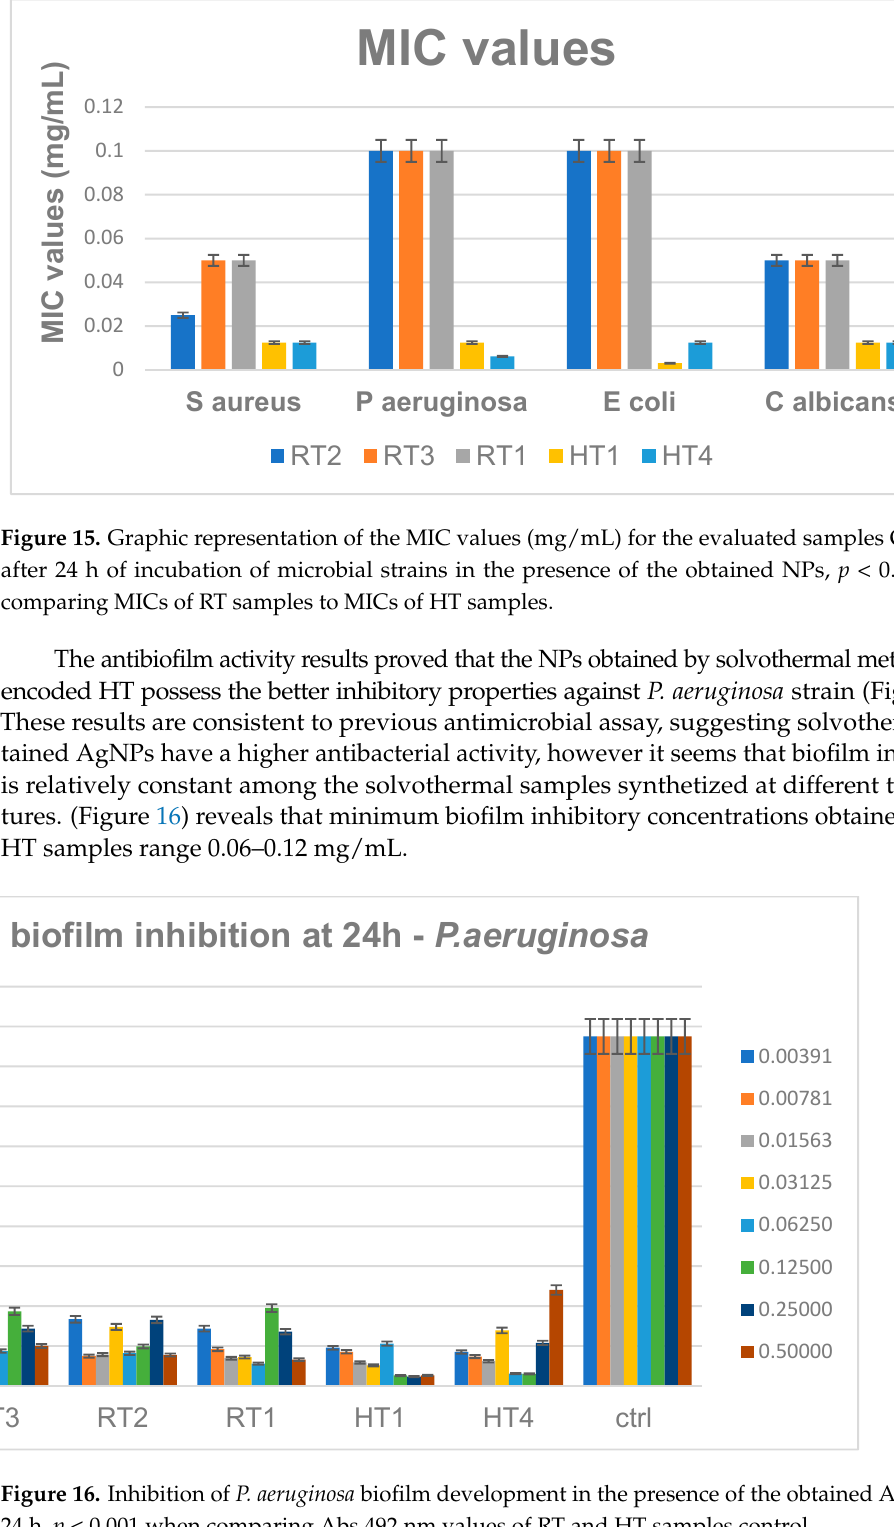
Figure 17. Inhibition of E. coli biofilm development in the presence of the obtained AgNPs for 24 h, p < 0.001 when comparing Abs 492 nm values of RT and HT samples to control . S. aureus biofilm development was constantly inhibited by all of the obtained AgNPs, when they were used in concentrations higher than 0.12 mg/mL (Figure 18). These results suggest that the Gram-positive biofilms may be more resistant to the activity of AgNPs regardless their synthesis route.